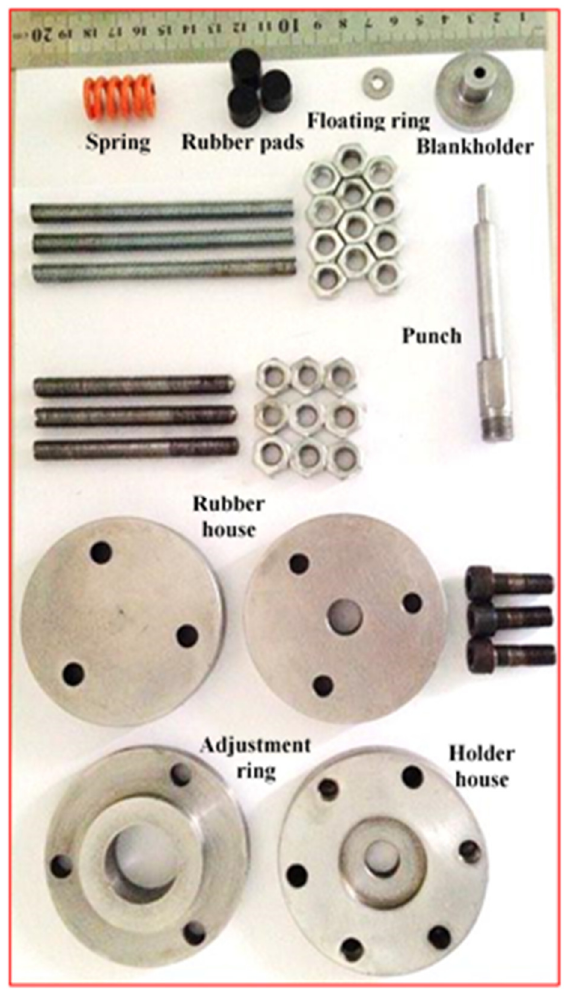
Fig. 10. Components of device.